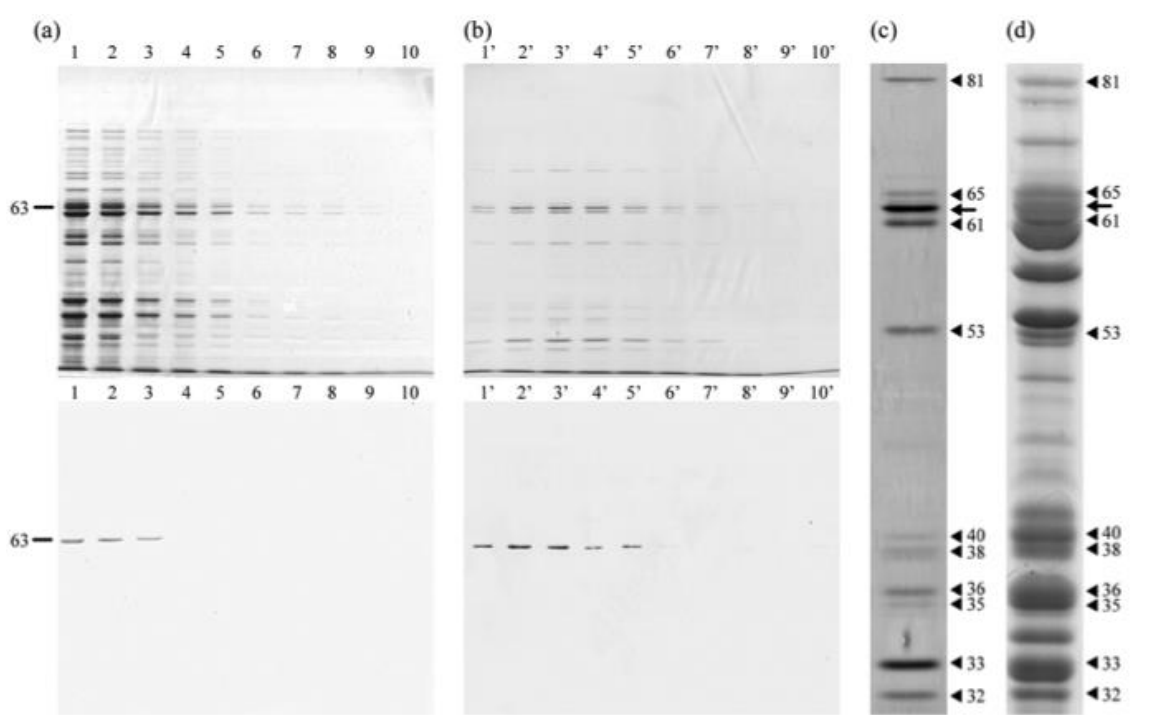
Figure 4. SDS-PAGE and immunoblots of fractions of DNA affinity column chromatography. Calf thymus DNA was used. ( a ) Fractions 1 – 10 eluted with Na, K-PB; ( b ) fractions 1′–10′ eluted with Na, K-PB containing 0.2 M NaCl. Upper, silver-stained gel. Lower, immunoblot with mAb3D1B9C4. ( c ) High magnification of a fraction number 3′ using silver staining. Not only PRP1 but also several silver staining bands were also confirmed. ( d ) CBB stained gel of IF cells of H. obtusa . Arrow, PRP1. Arrowheads, other bands eluted. Bands in ( c ) match the bands in ( d ).